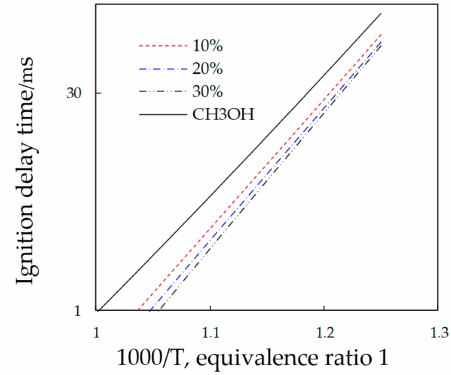
Figure 8. E ff ect of nitromethane on methanol